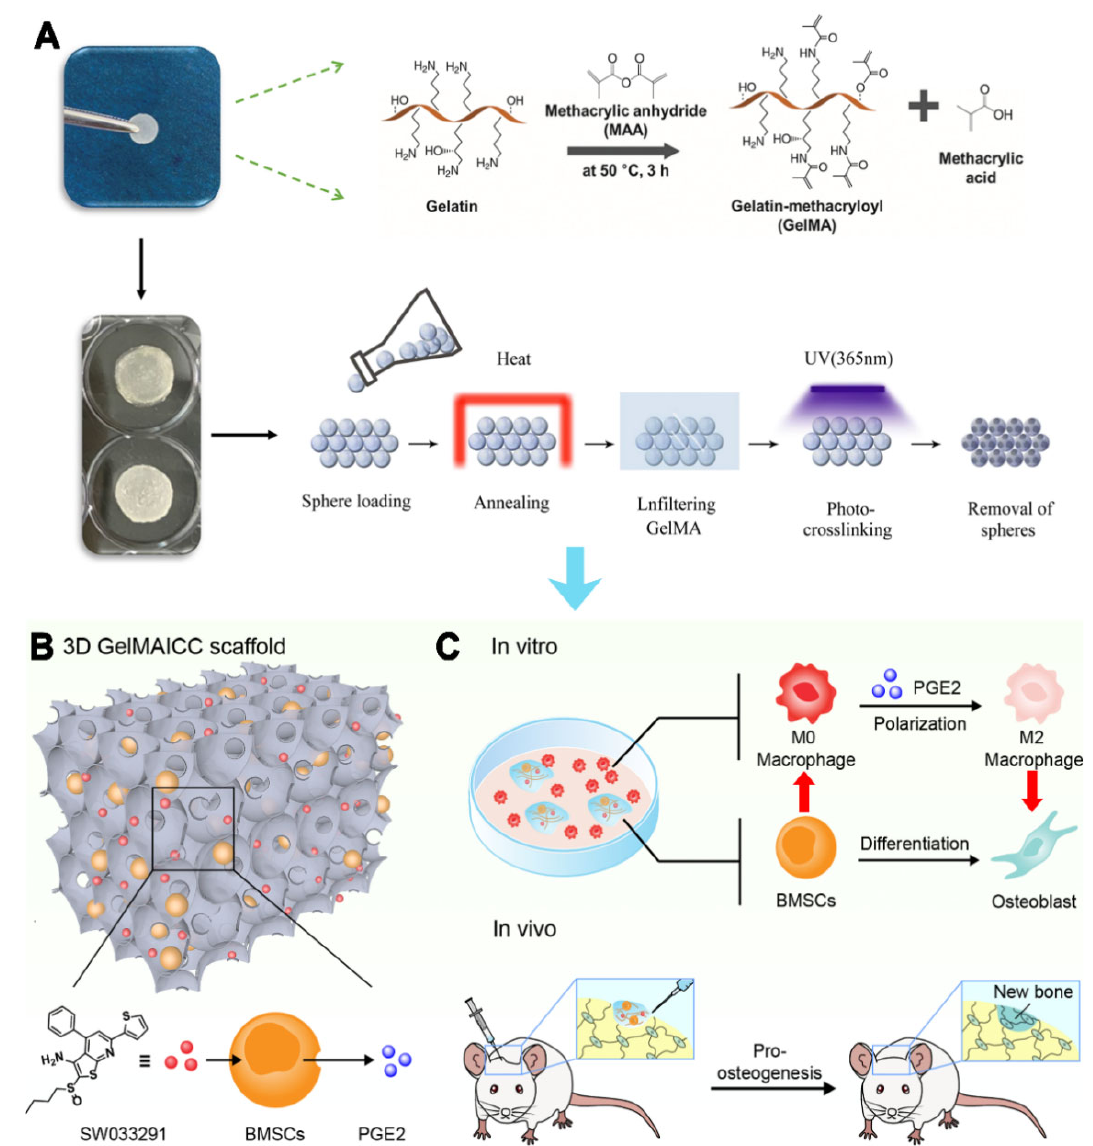
Figure 1. Schematic illustration of ( A ) Fabrication of GelMA ICC scaffolds with interconnected porous architectures; ( B ) PGE2 release of BMSCs mediated by SW033291; ( C ) GelMA ICC scaffolds with SW033291 promoted osteogenic differentiation by the immunoregulatory loop between BMSCs and macrophages in vitro and in